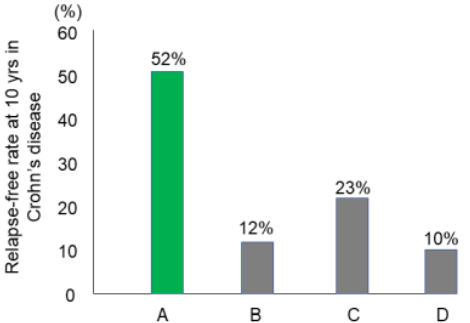
Figure 14. The relapse-free rate at 10 years after the first induction in Crohn ’ s disease. A: Report from Japan. Induction by infliximab and a plant-based diet as first-line therapy followed by the recommendation of adherence to a plant-based diet ( n = 26) [84] B: Report from Denmark on induction by conventional therapy ( n = 373) [58]. C: Report from seven European countries and Israel on induction by conventional therapy ( n = 358) [59]. D: Report from Norway on induction by conventional therapy ( n = 237) [60].